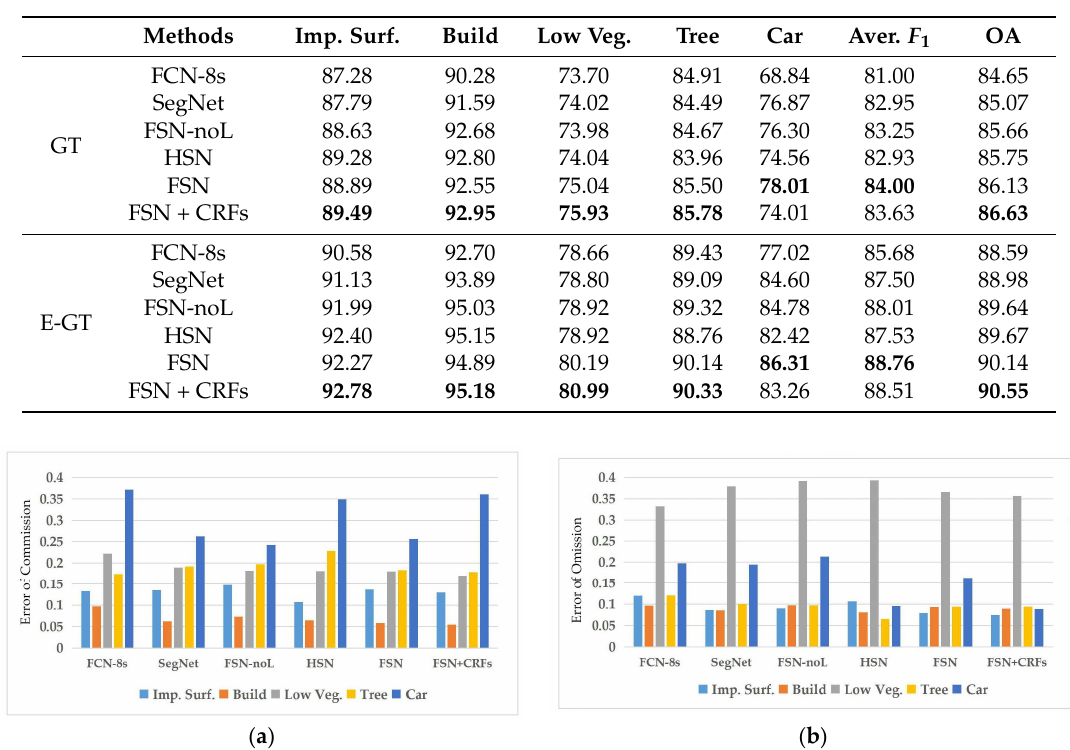
Table 7. Experimental results on Vaihingen test set.